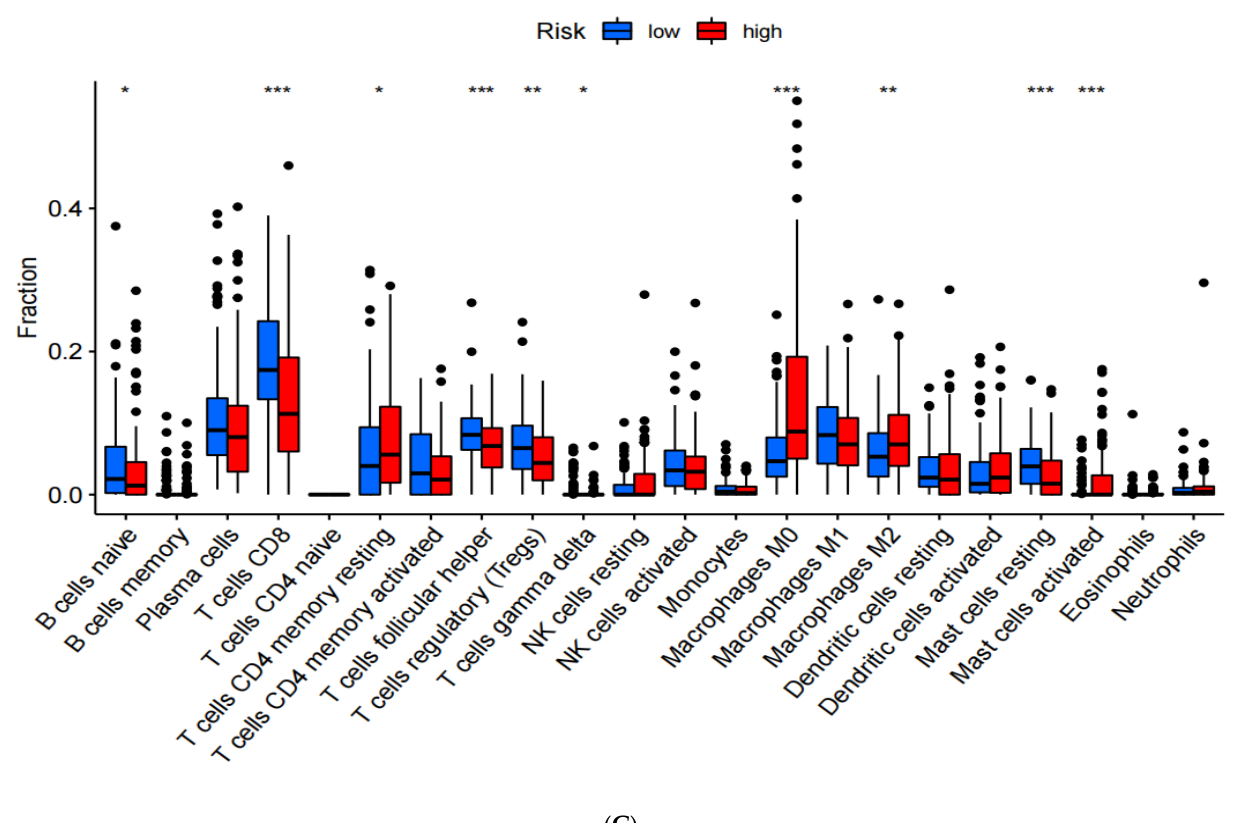
Figure 5. The relationships between the (6-anoikis-related gene) 6-ANRG signature and the immune cells. ( A ) The box plot shows the correlation between the risk scores and the immune subtypes. ( B ) The relative proportion of the infiltrating immune cells in CESC patients from the TCGA cohort. ( C ) The box plot shows the expression patterns in the 22 immune cells from the different risk groups. * p < 0.05, ** p < 0.01, and *** p < 0.001.